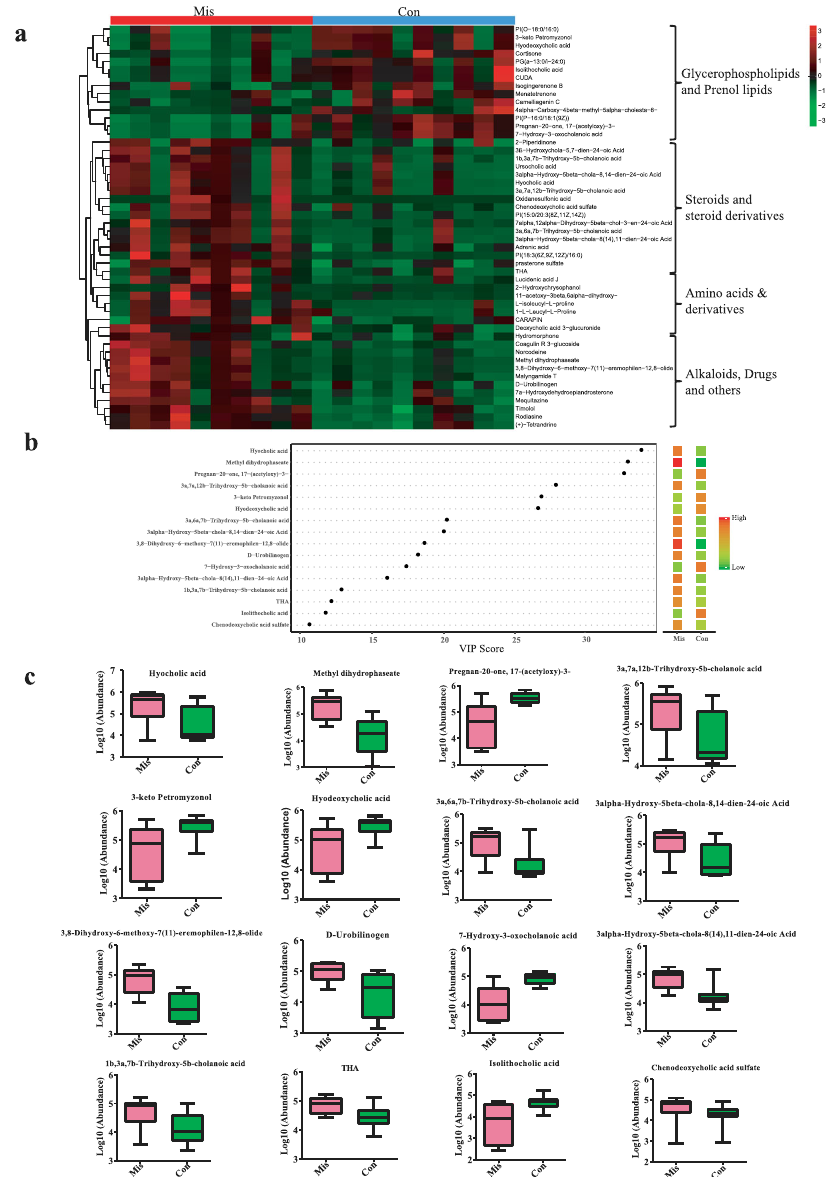
Fig. 5 Distinct metabolites, as identi fi ed by clustering and multivariate analyses, between the miscarriage (Mis) and control (Con) groups. a Hierarchical clustering analysis (HCA) for the miscarriage and control group metabolites based on their z-normalized abundances. b The discriminatory metabolites of top 16 VIP scores which obtained from the OPLS-DA models. c Abundance comparisons of metabolites between the miscarriage and control groups. The bar are shown as mean ±